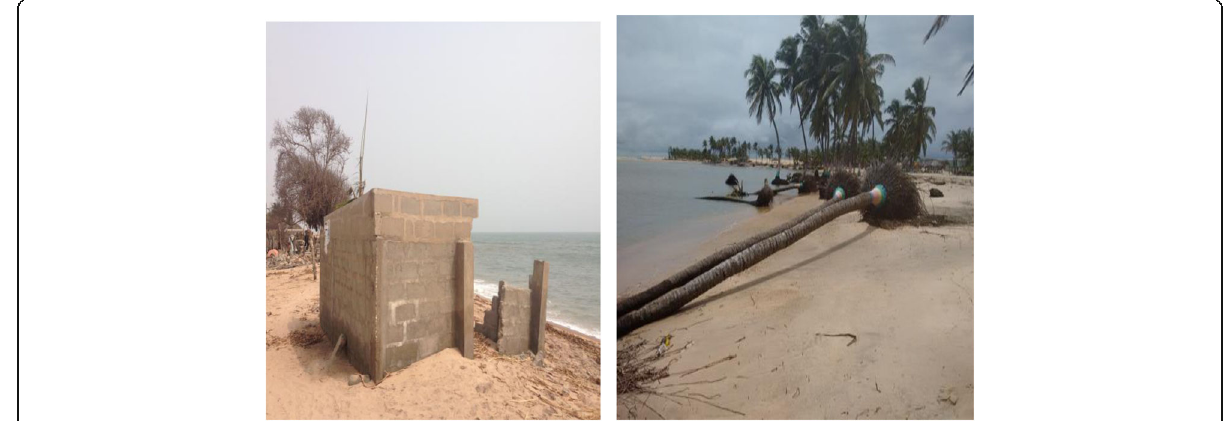
Fig. 3 Destruction at Fuveme and Ada due to increased